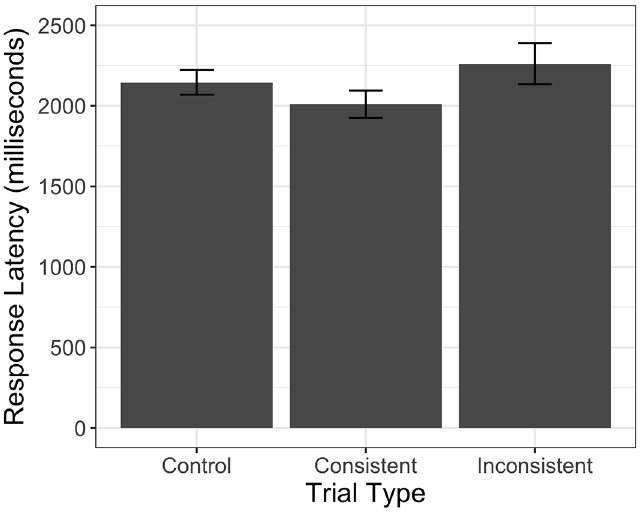
Figure 5. Effect of trial type on response latency in Experiment